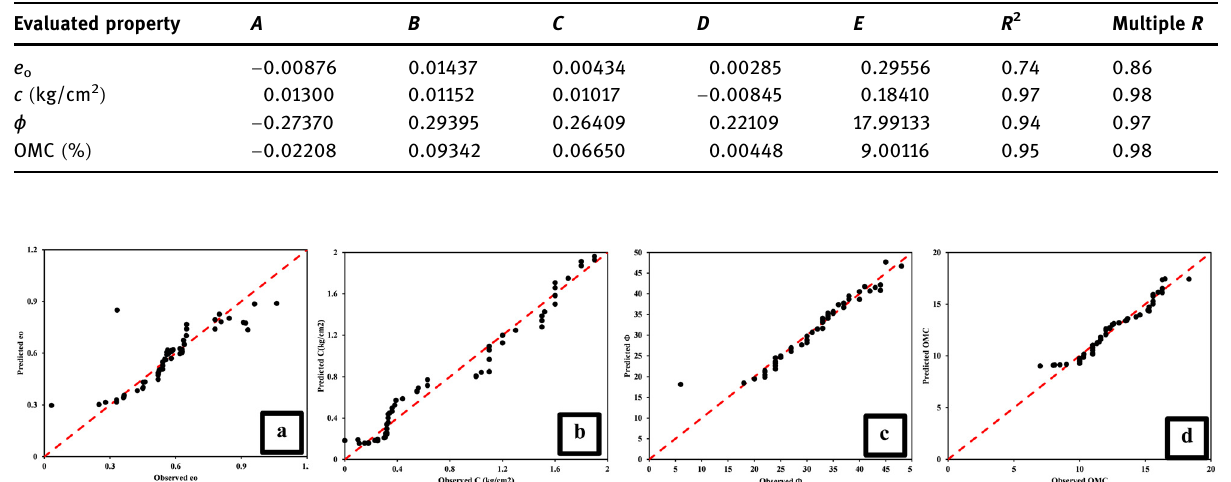
Figure 10: The variation between the predicted and observed soil properties for Kirkuk city: ( a ) e o , ( b ) c ( kg/cm 2 ) , ( c ) ϕ , and ( d ) OMC ( % ) .